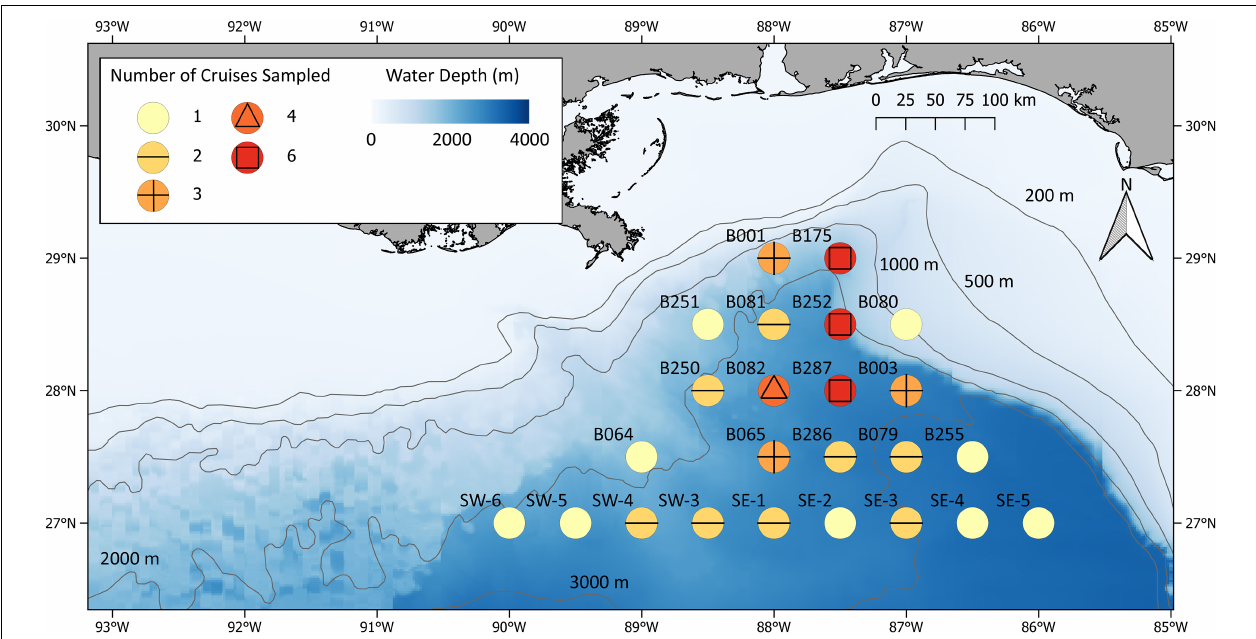
FIGURE 2 | DEEPEND MOC10 stations sampled between 2015 and 2018. Symbol colors represent the number of cruises during which each location was